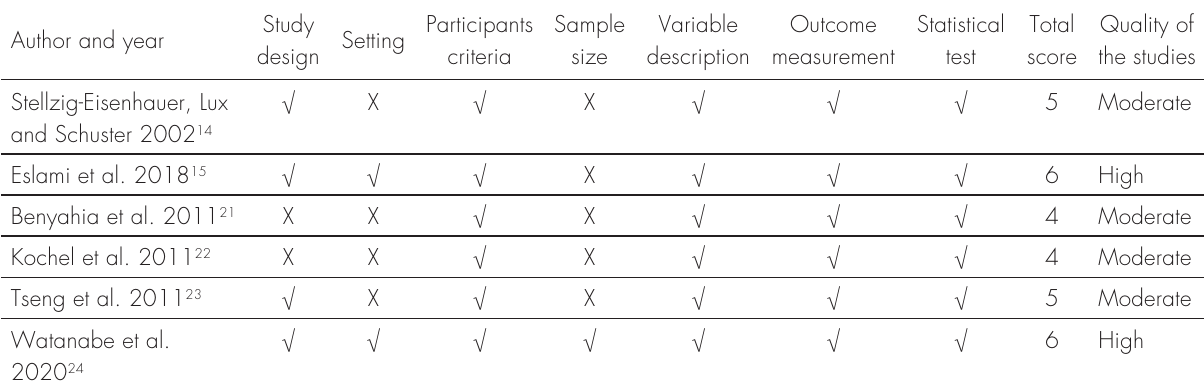
Table III. Risk of bias of included